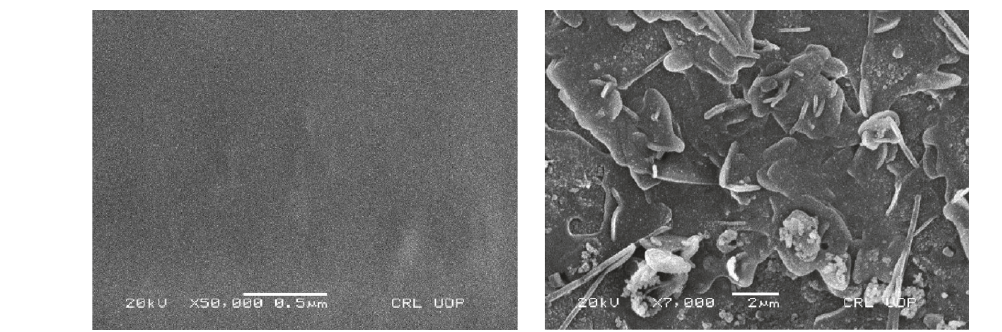
(a) SEM of the membrane before Zn (II) transport (b) SEM of membrane at 0.1mol/dm 3 of NaOH ([HCl] in feed solution = 2.0mol/dm 3 , [TDDA] in